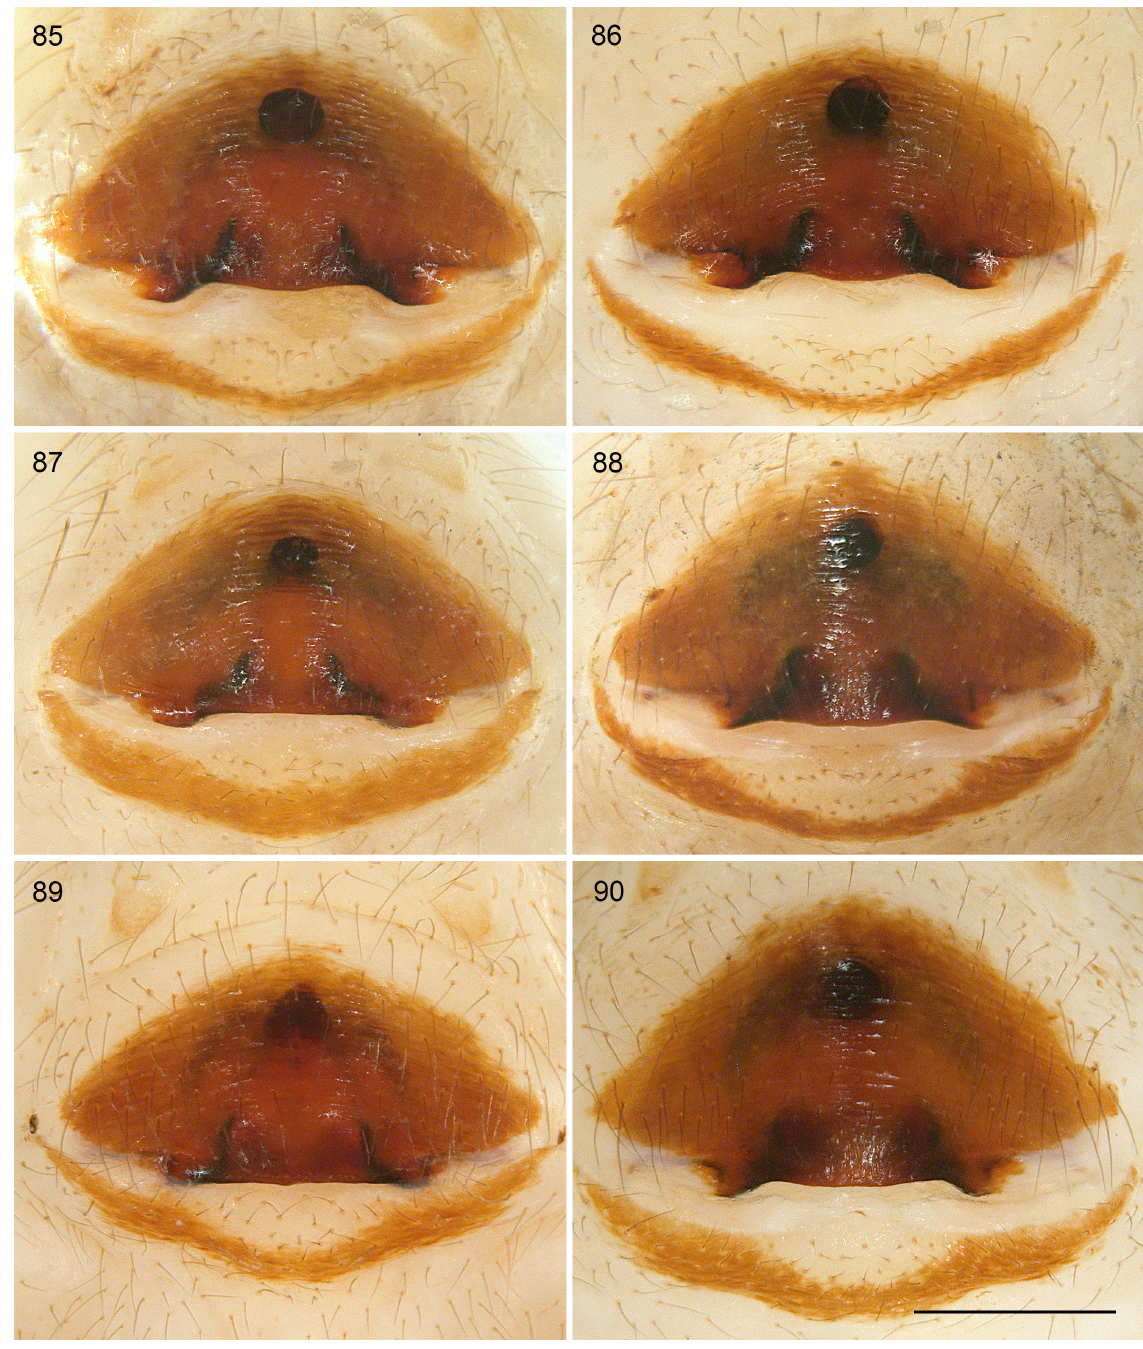
Figs 85–90. Stygopholcus montenegrinus Kratochvíl, 1940; epigyna, ventral views. 85-86 . Studenačka pećina, Montenegro (ZFMK (Ar 22201)). 87 . Golubinja pećina, Montenegro (CMK). 88 . Ljuboviči, Montenegro (CMK). 89 . Nëngurit Cave, Albania (CMK). 90 . Petnjik Cave, Montenegro (CMK). Scale bar: 0.5 mm (all at same